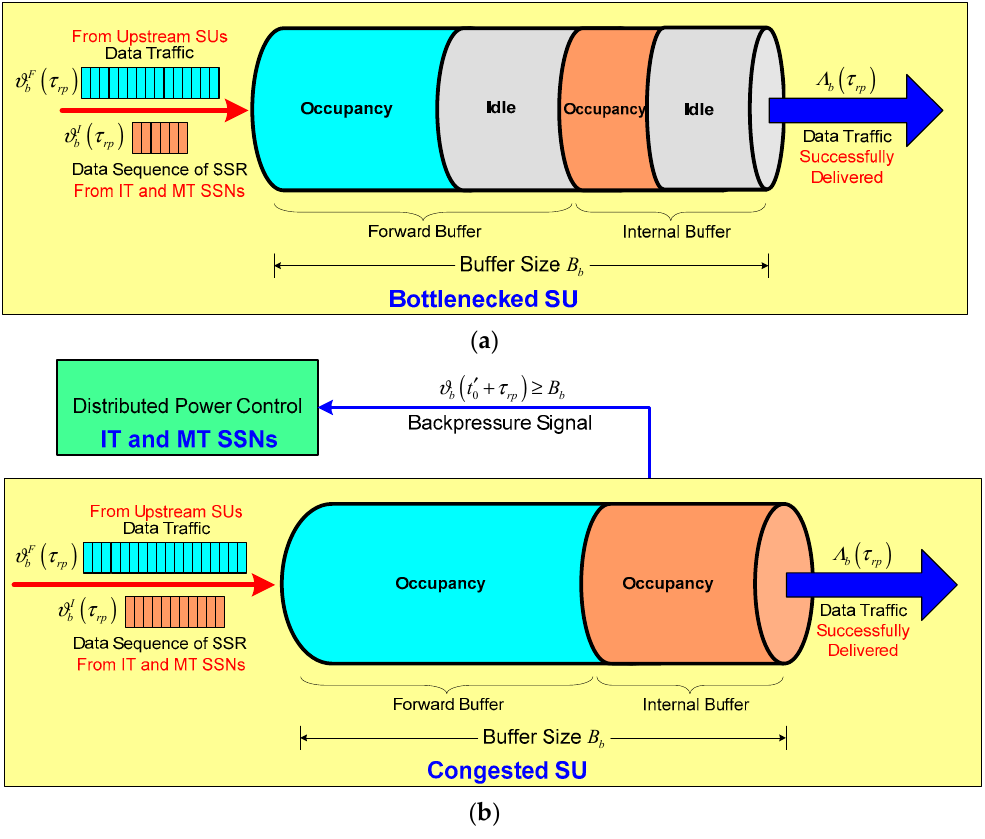
Figure 3. Illustration of buffer based congestion detection at bottlenecked secondary user (SU) b . ( a ) Normal status without buffer overflow; ( b ) Congestion occurrence due to buffer overflow.